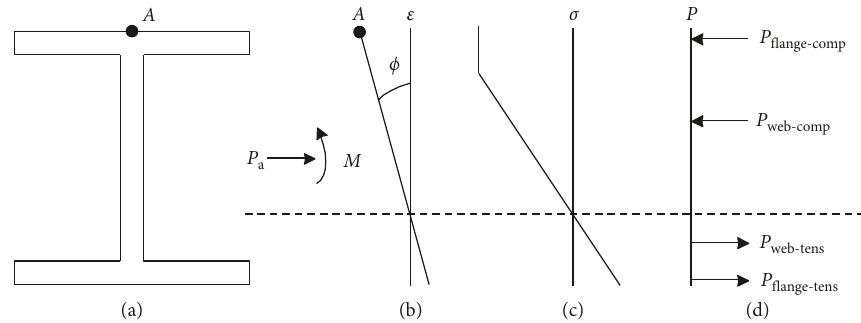
Figure 1: Moment-curvature analysis for a section. (a) Cross section. (b) Strain. (c) Stress. (d) Force.